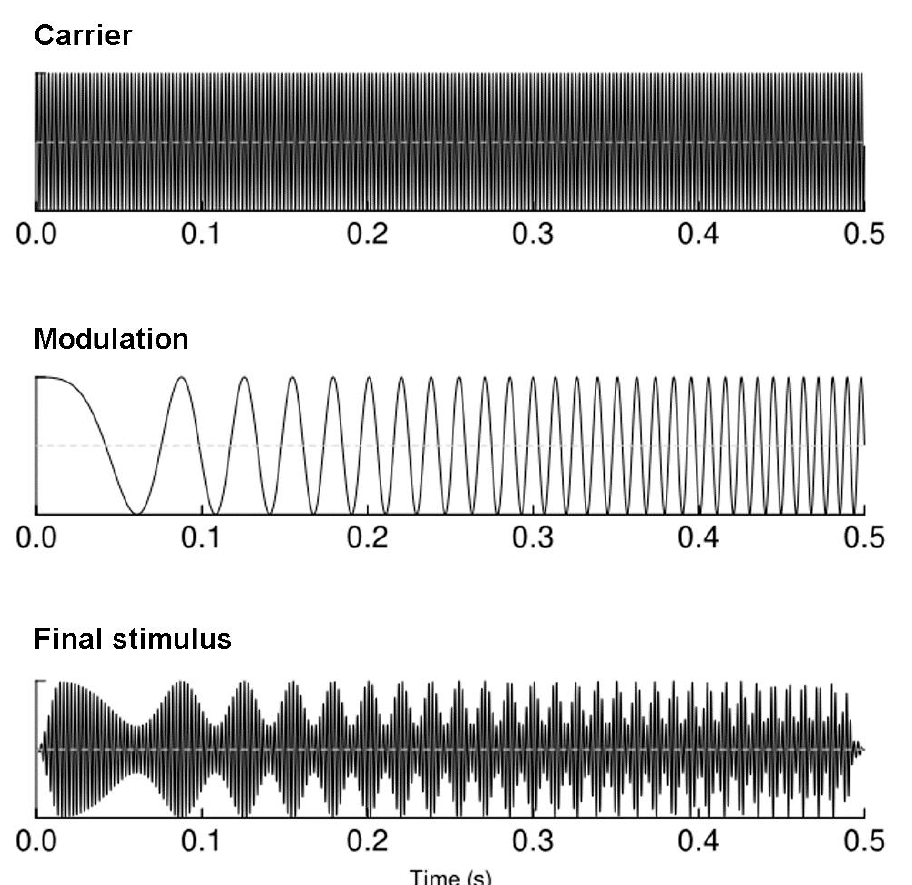
Figure 1. A schematic representation of the stimulus used to elicit envelope following responses.